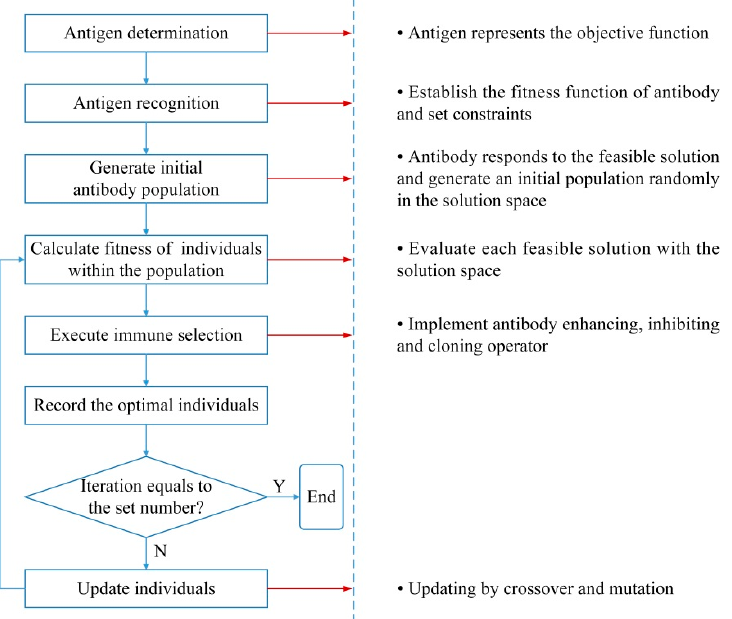
Figure 2. The AC groups optimization process by artificial immune algorithm.